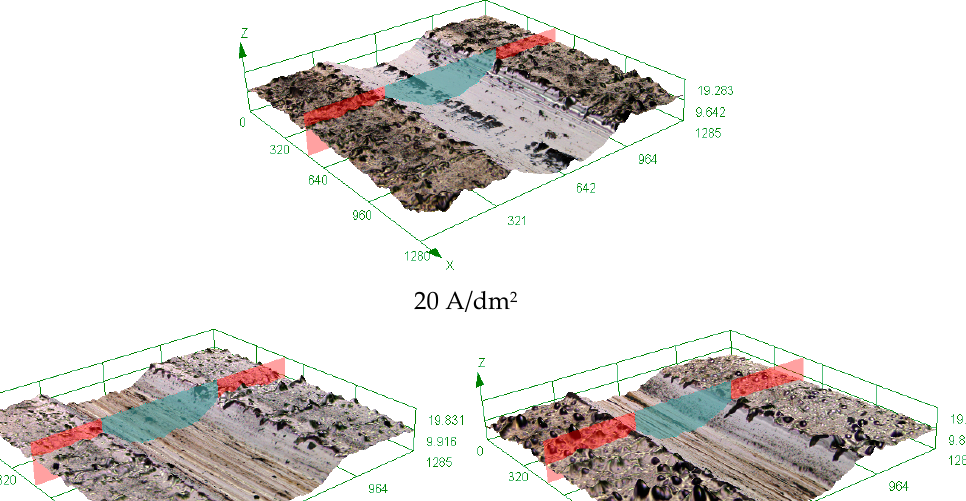
Figure 7. Relationship between microhardness of composite coatings and current density.